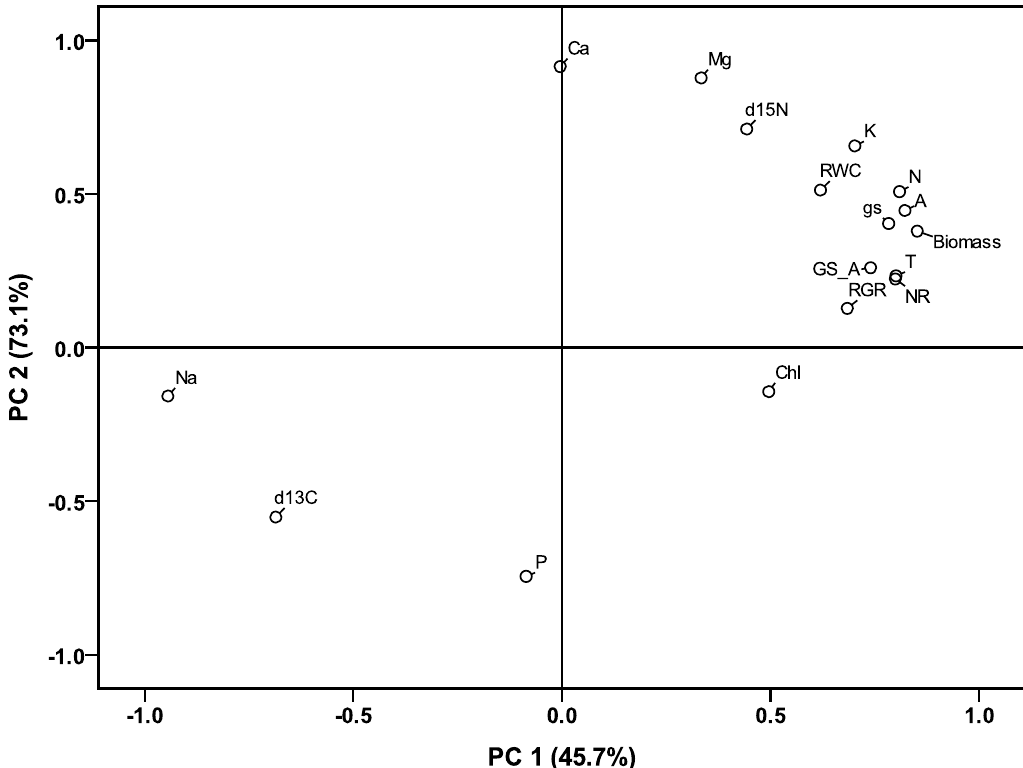
Figure 5. Principal component analysis (PCA) of biomass, RGR, RWC and the traits related to water, N and ions in the shoots in the salinity treatments. All abbreviations are as defined in Tables 3–5.